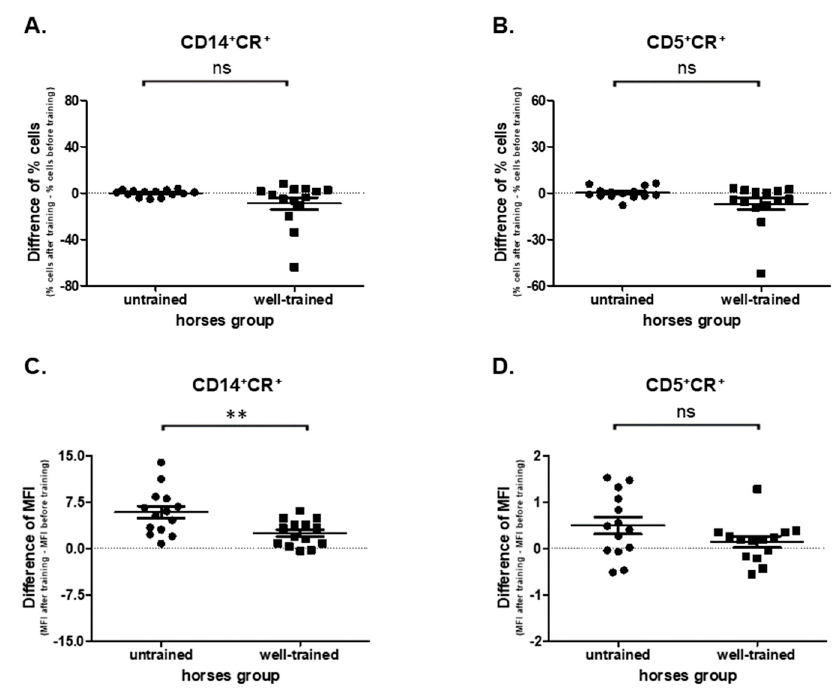
Figure 5. Graphic representation showing percentages of positive cells: CD14 + CR + ( A ), CD5 + CR + ( B ), and CD14 + MHCII + gated from total lymphocytes / monocytes and median fluorescent intensity of CR (CellRox) in CD14 + ( C ) and CD5 + ( D ) cells. The results are presented as the mean ± SEM. Significance levels are: ** p < 0.01.